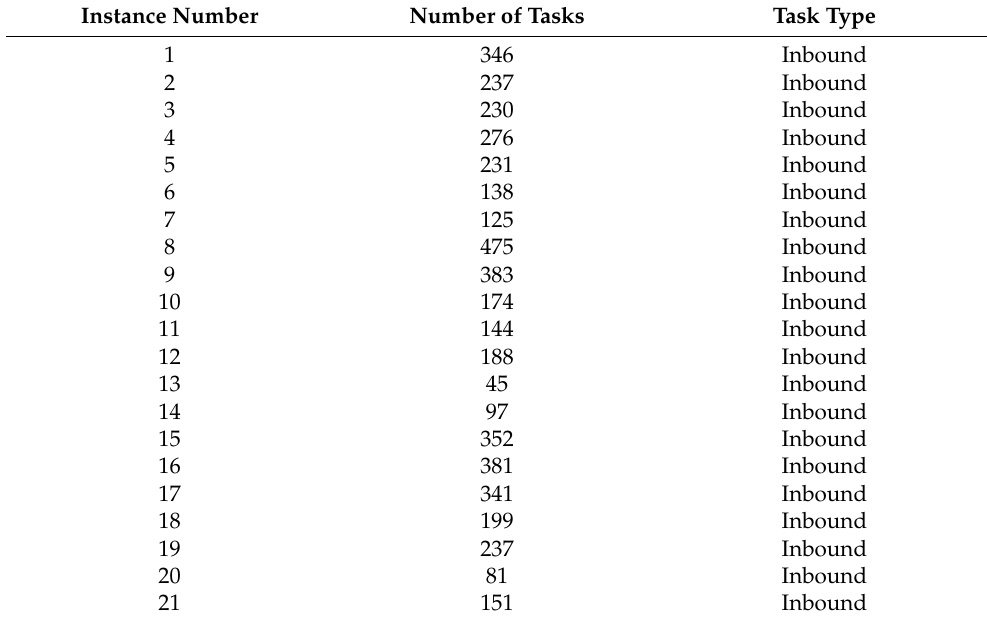
Table 3. The structure of problem